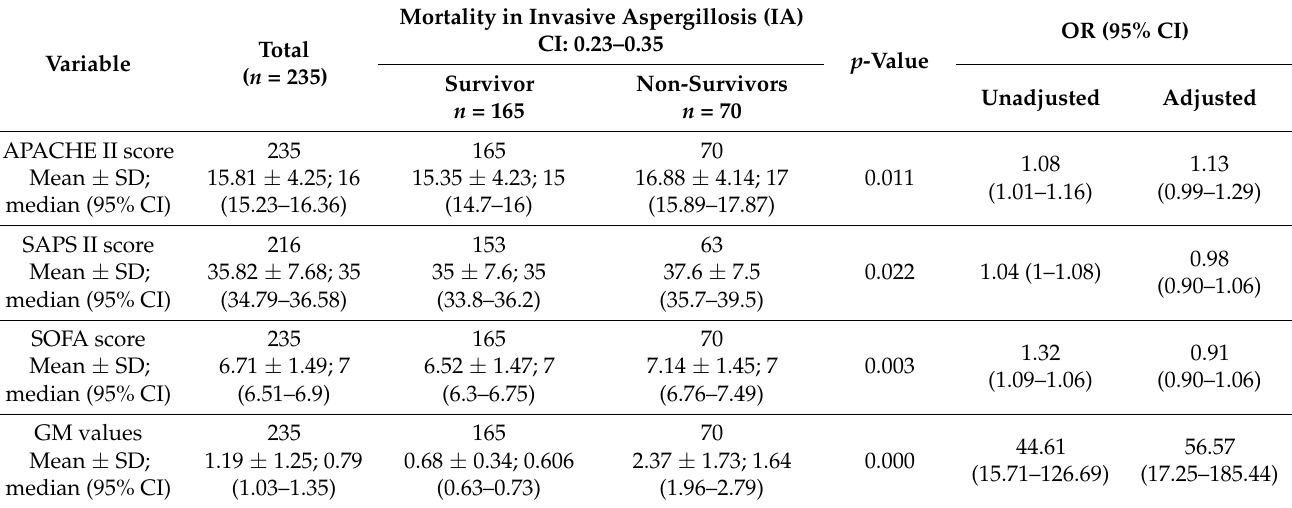
Figure 2. Calculated galactomannan antigen OD index cut-off for mortality with area under the curve (AUC). Table 4. Univariate and multivariate analysis of the severity scores obtained by three ICU scoring systems and galactoman- nan antigen